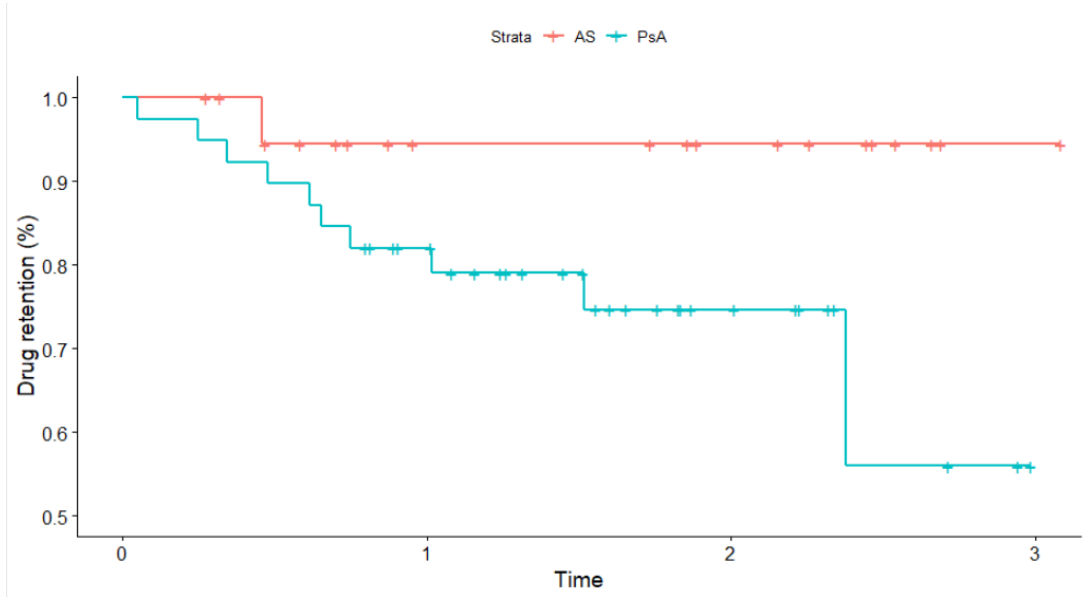
Figure 3. Crude Kaplan – Meier survival curve for drug retention compared across disease types for patients receiving secukinumab in second-line. Time is expressed in years. The p -value based on the log-rank test is 0.07. Tick marks indicate censored events.